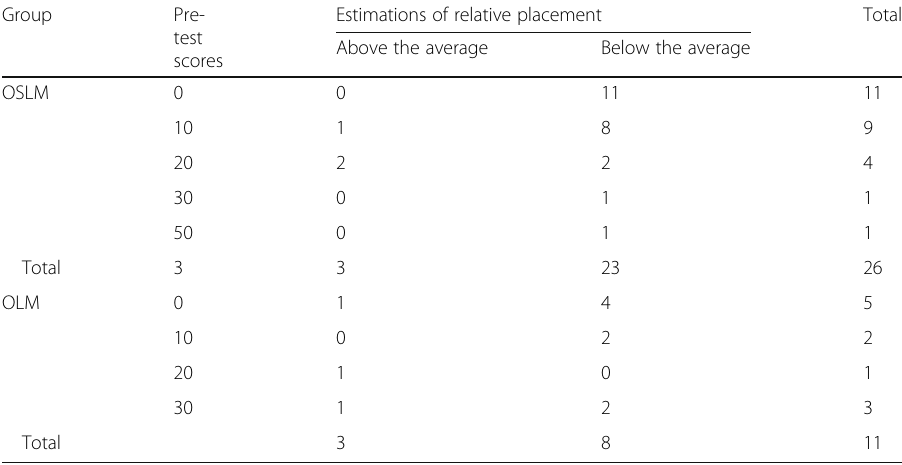
Table 11 The students ’ pre-test scores and their estimations of their relative placement Group Pre- Estimations of relative placement Total test Above the average Below the average scores OSLM